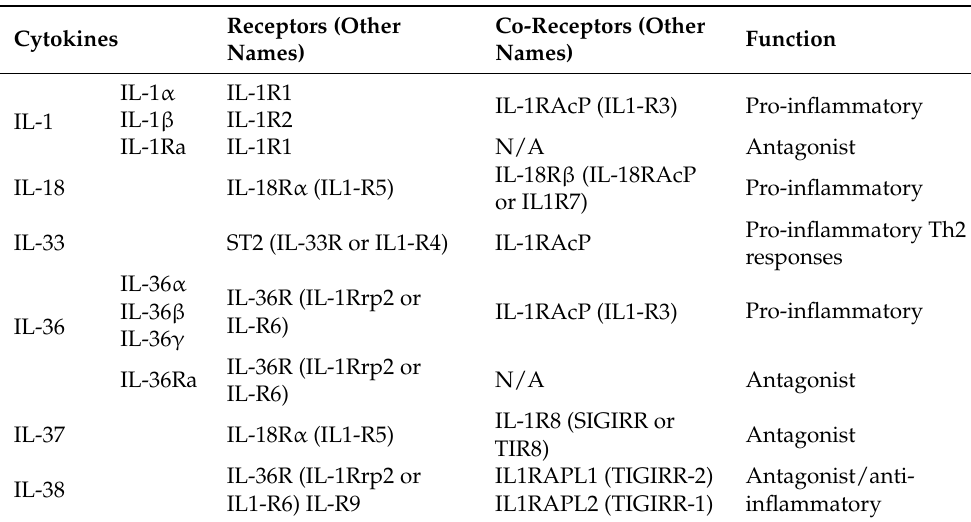
Table 1. IL-1 family cytokine members